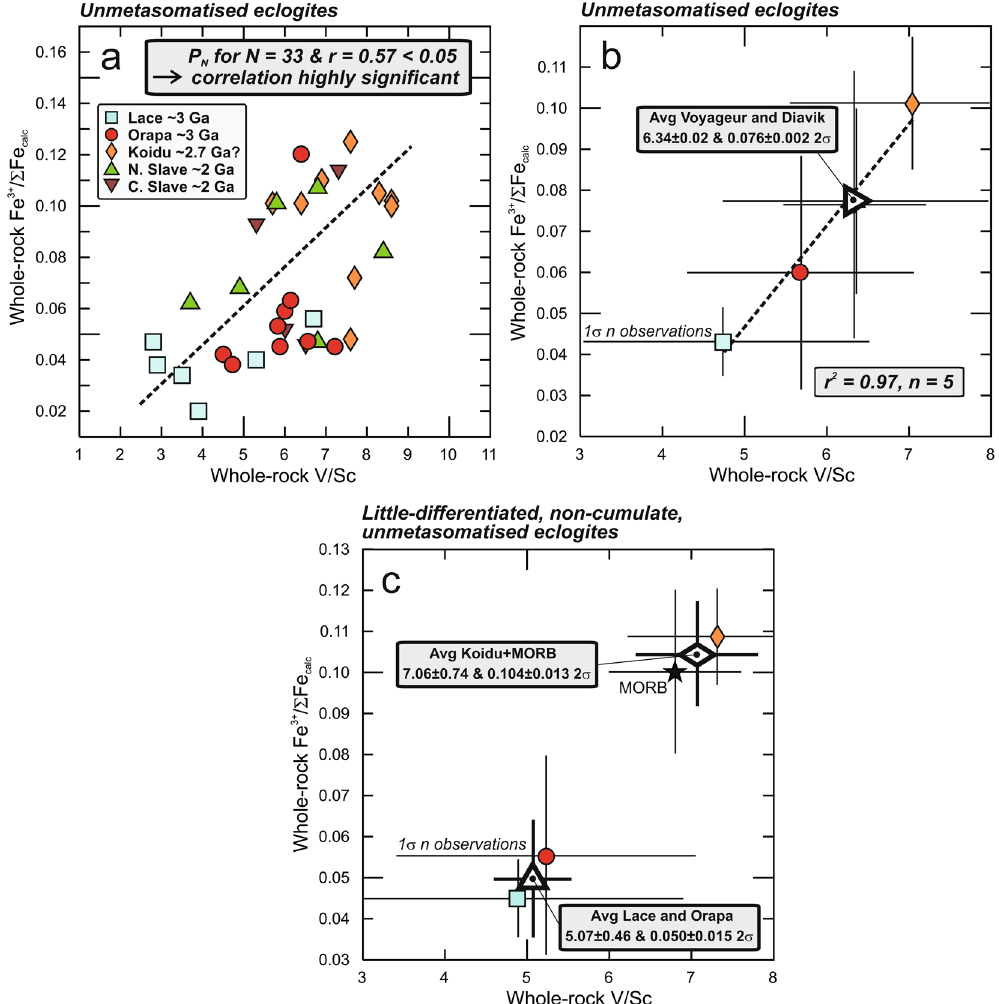
Figure 3. Sympathetic behaviour of Fe 3 + / Σ Fe and V/Sc. Reconstructed whole rock mantle eclogite showing ( a ) all individual non-metasomatised samples, ( b ) averages for non-metasomatised samples per locality and ( c ) averages only for non-metasomatised, non-cumulate and little-differentiated samples (that is, excluding high-Ca and gabbroic eclogites 14 ). Although the correlation coefficient in ( a ) is seemingly low (r 2 = 0.32), there is a probability < 0.5% that the two variables are uncorrelated for the number of data points in the regression (n = 33), and the correlation is highly significant 38 . Proterozoic eclogite suites from the northern and central Slave craton have a strong cumulate character, implying that their Fe 3 + / Σ Fe, and their V/Sc for accumulation under oxidising conditions, are lower than for eclogites with melt-like protoliths, and they are therefore not considered in ( c ). In ( b , c ) averages for V/Sc encompass all available values (references in Supplementary Dataset) and are not limited to samples for which Fe 3 + / Σ Fe has been determined; error bars for individual suites are 1 standard deviation for n averaged values